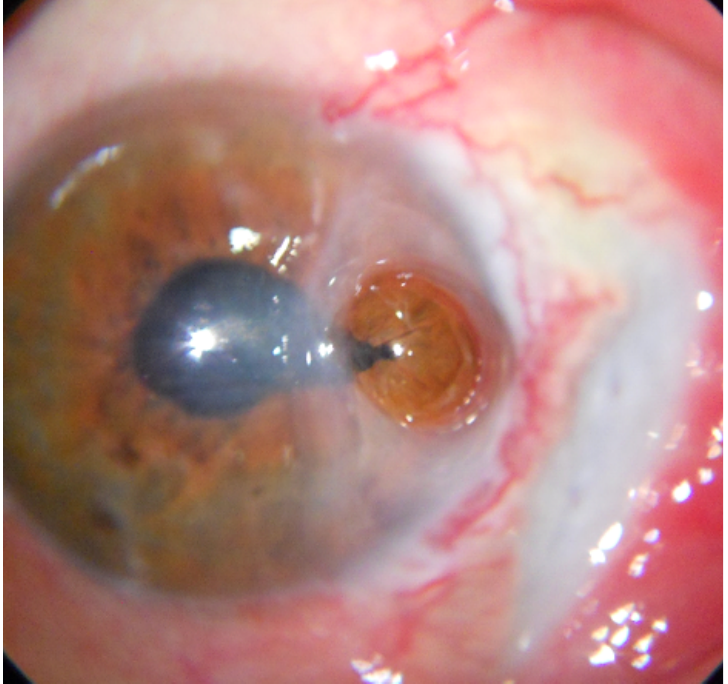
Figure 1. Corneal perforation (3.5 mm) with iris presenting at the site with extensive corneo-limbo-scleral